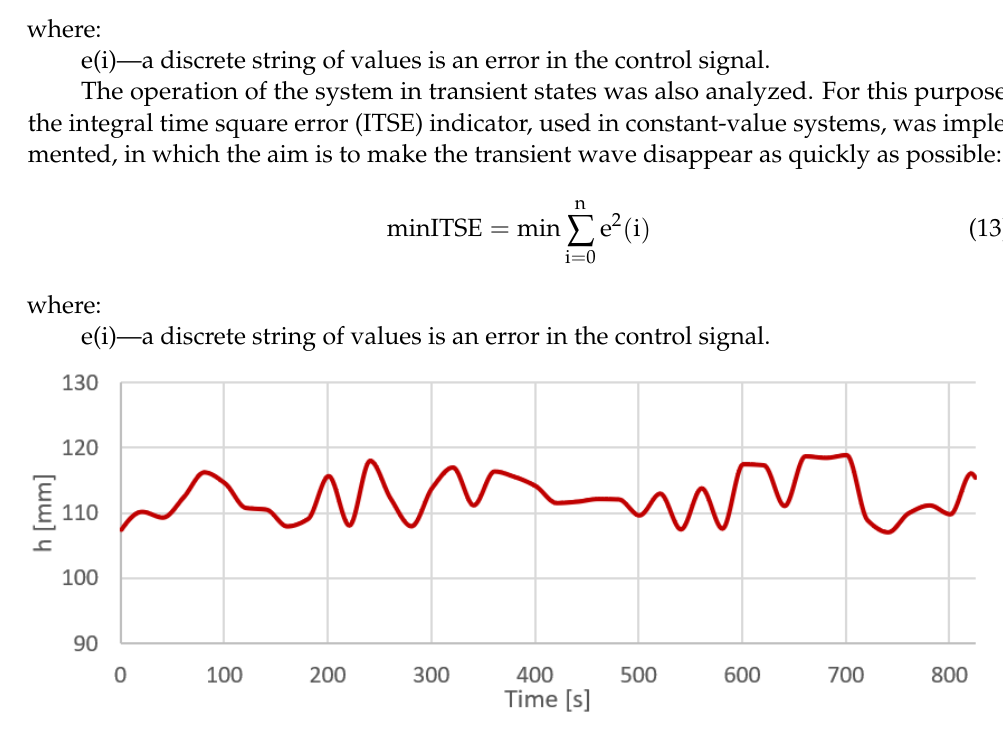
Figure 5. Waveform of changes in the position of the distribution layer in compartment 1 when using the traditional PID controller.